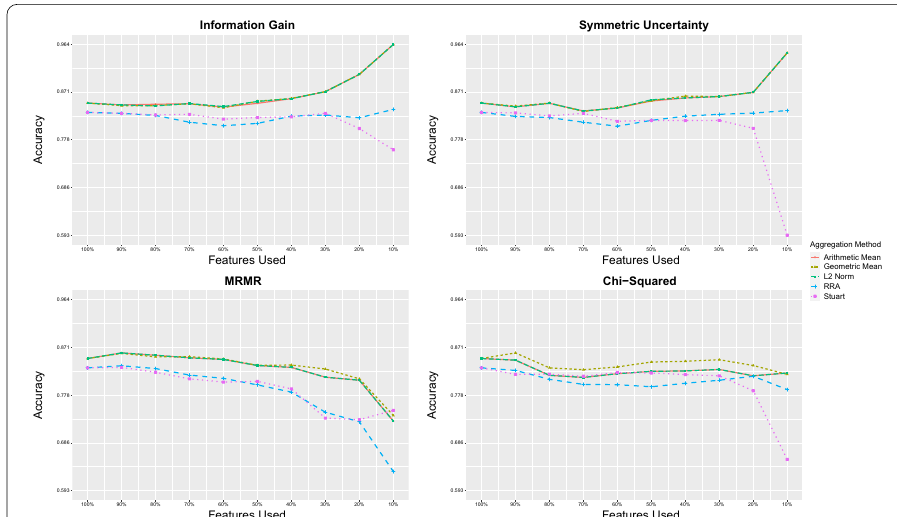
Fig. 6 Musk dataset classification results